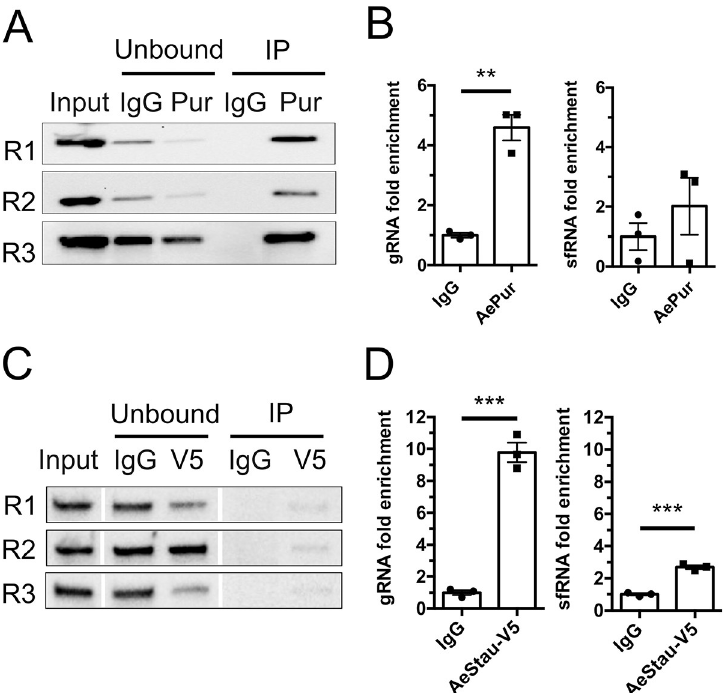
Fig 2. Binding affinities of AePur and AeStaufen to DENV2 3’UTR and sfRNA. (A) Western blots of AePur immunoprecipitates from orally-infected mosquito lysates. (B) gRNA and sfRNA fold enrichments in AePur immunoprecipitates as compared to IgG control. (C) Western blots of AeStaufen-V5 (AeStau-V5) immunoprecipitates from infected C6/36 cell lysates. (D) gRNA and sfRNA fold enrichments in AeStaufen immunoprecipitates as compared to IgG control. (A, C) Three biological repeats (R1-3) are shown. (B, D) Bars show mean ± s.e.m. from three repeats. �� , p-value < 0.01; ��� , p-value < 0.001 as determined by unpaired